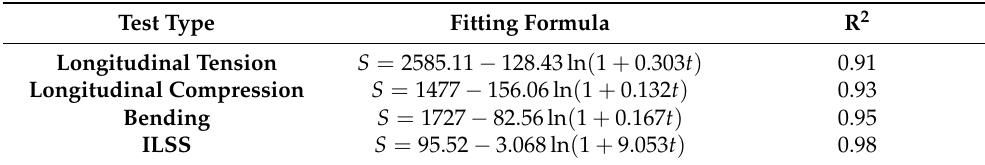
Table 4. Remaining strength model fitting